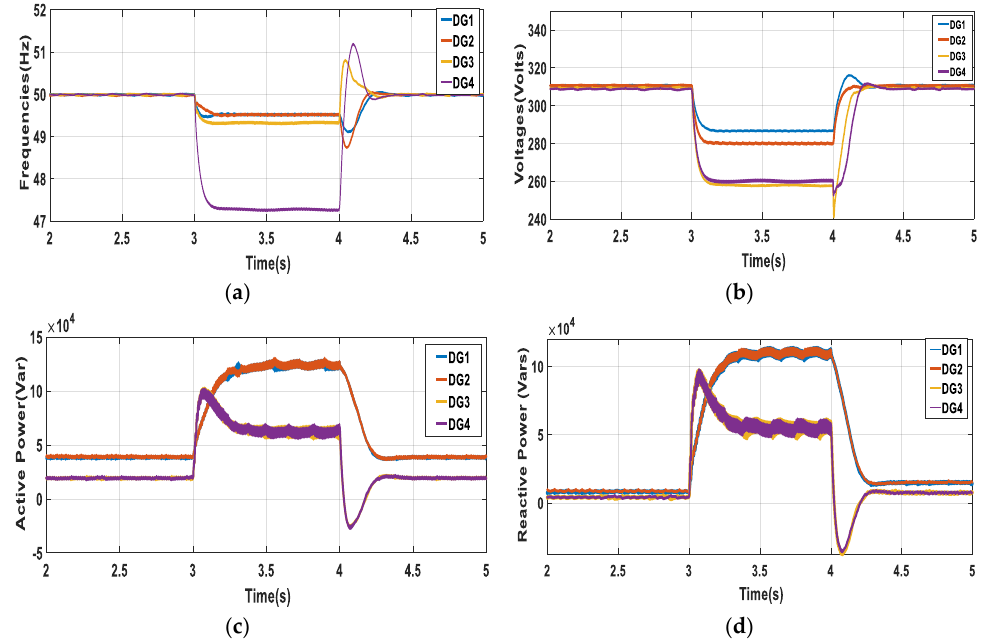
Figure 17. Output results of 4 DGs: ( a ) frequencies, ( b ) voltages and ( c ) active power and ( d ) reactive power for case 7.